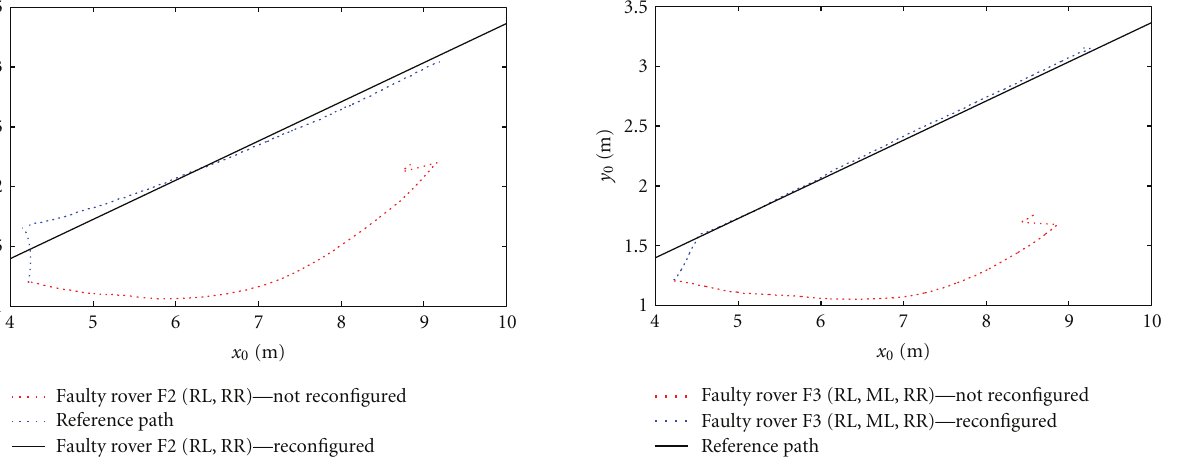
Figure 20: Fault-tolerant control performance for ExoMars Rover under fault